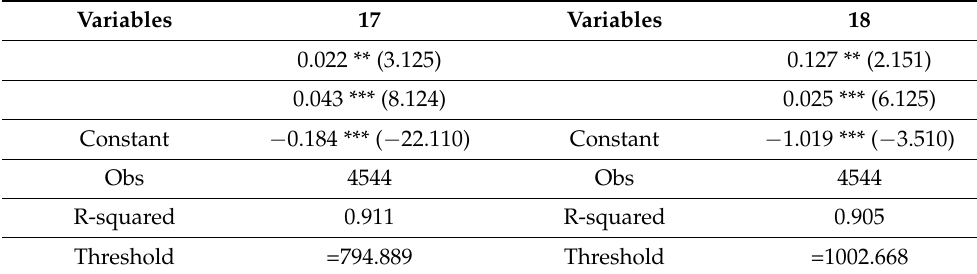
Table 5. Regression results of the threshold